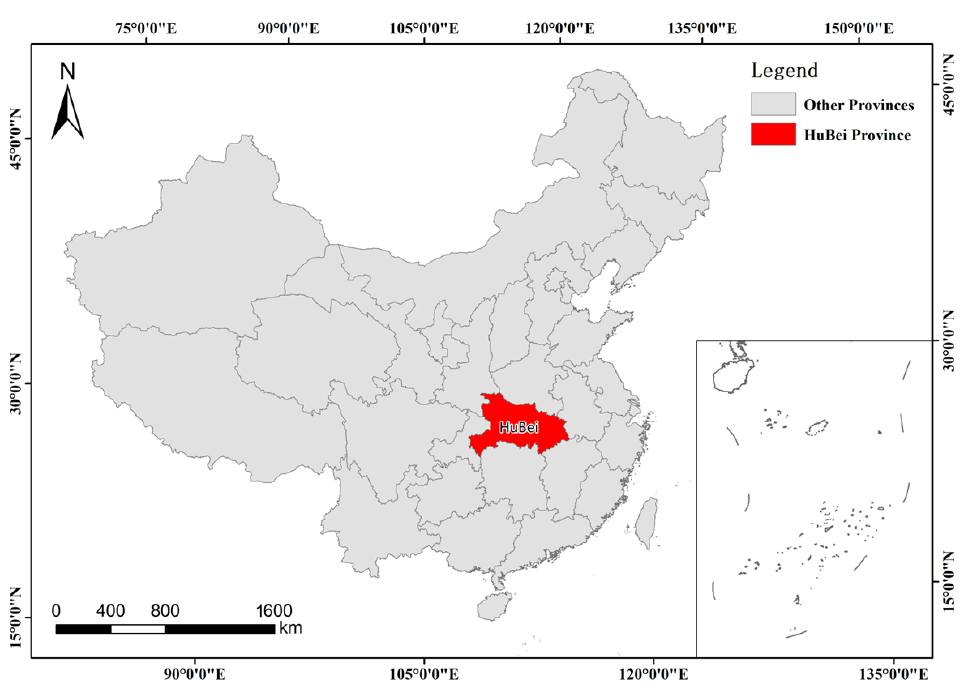
Figure 1. Location of Hubei Province.